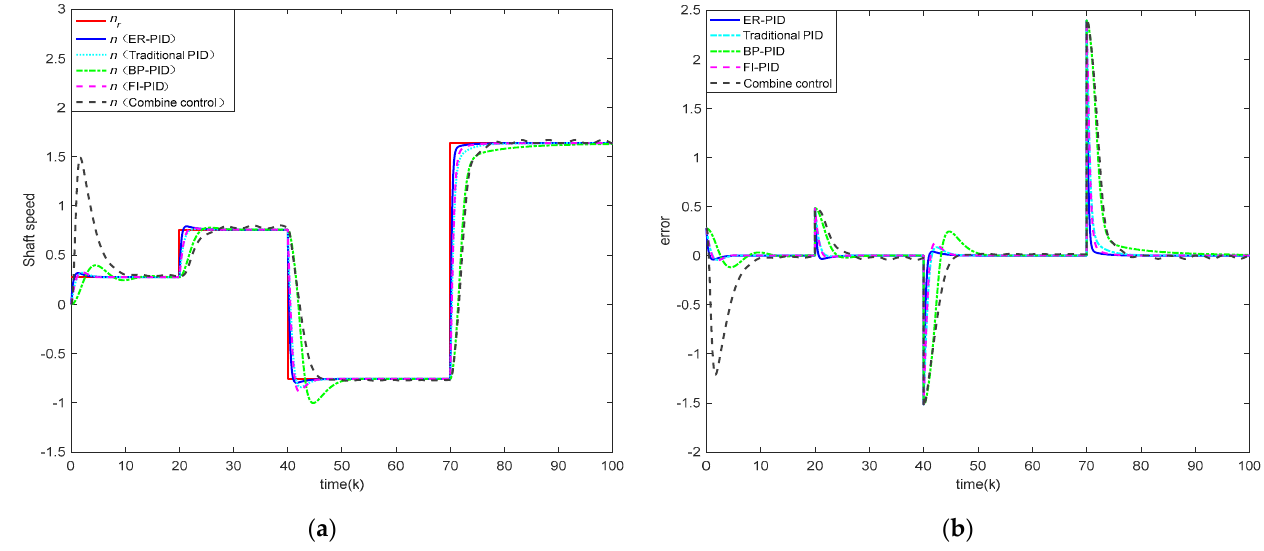
Figure 13. Tracking results and tracking error of the 5 methods. ( a ) Tracking results for 5 method that n ( k ) tracks n r ( k ). ( b ) Tracking errors for 5 method that n ( k ) tracks n r ( k ).